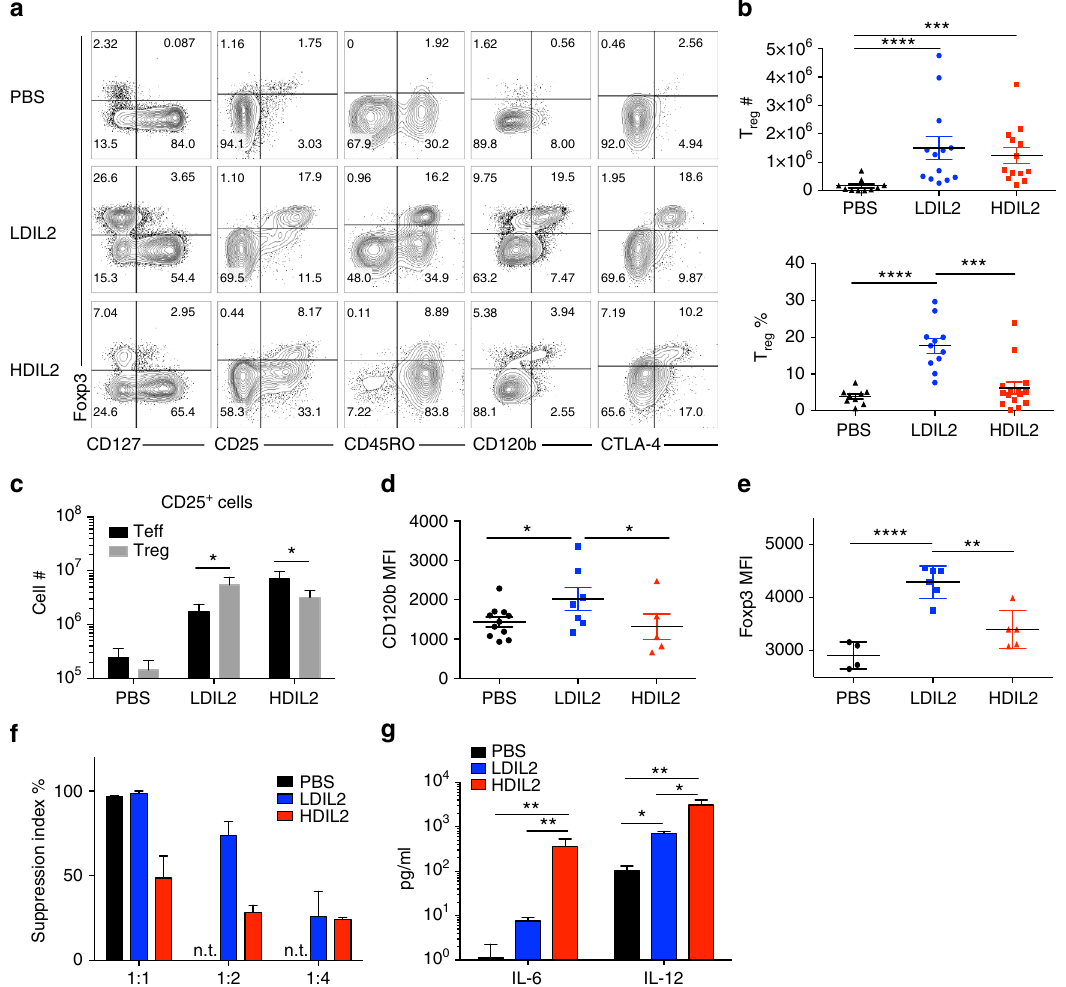
Fig. 4 Defective regulatory T cell function in high-dose IL-2 human immune system mice. 10 − 14-week-old human immune system (HIS) mice were injected with PBS, low-dose IL-2 (LDIL2) or high-dose IL-2 (HDIL2). Mice were killed at D6 post injection. a Representative fl ow cytometric data showing the phenotypes of splenic Foxp3 + regulatory T (T reg ) cells. The data are representative of two independent experiments. b Percentages and numbers of Foxp3 + T reg cells within splenic CD45 + CD3 + CD4 + T cells. The data are pooled from four independent experiments. c Absolute cell counts of CD25 + cells within CD45 + CD3 + CD4 + Foxp3 + T reg and CD45 + CD3 + CD4 + Foxp3 − effector T (T eff ) cells. d , e Mean fl uorescence intensity (MFI) ± SEM for CD120b and Foxp3 in CD3 + CD4 + CD127 − Foxp3 + T reg cells. The data are representative of four independent experiments. f CD45 + CD3 + CD4 + CD25 high CD127 − T regs were sorted and mixed with CFSE labeled CD45 + CD3 + CD4 + CD25 − CD127 + T eff cells at the ratio of 1:1, 1:2, and 1:4 in the presence of Dynabeads at a cell to beads ration of 1:8. The suppression index is calculated as [100 × (1 − %CFSE low T eff cells in coculture/%CFSE low T eff alone)]. NT = not tested. The data are the representative of two independent experiments. g Levels of cytokine IL-6 and IL-12 were analyzed from sera of indicated groups. The data are pooled from four independent experiments. * P < 0.05, ** P < 0.01, *** P < 0.001, **** P < 0.0001 by 1-way ANOVA test with a Tukey